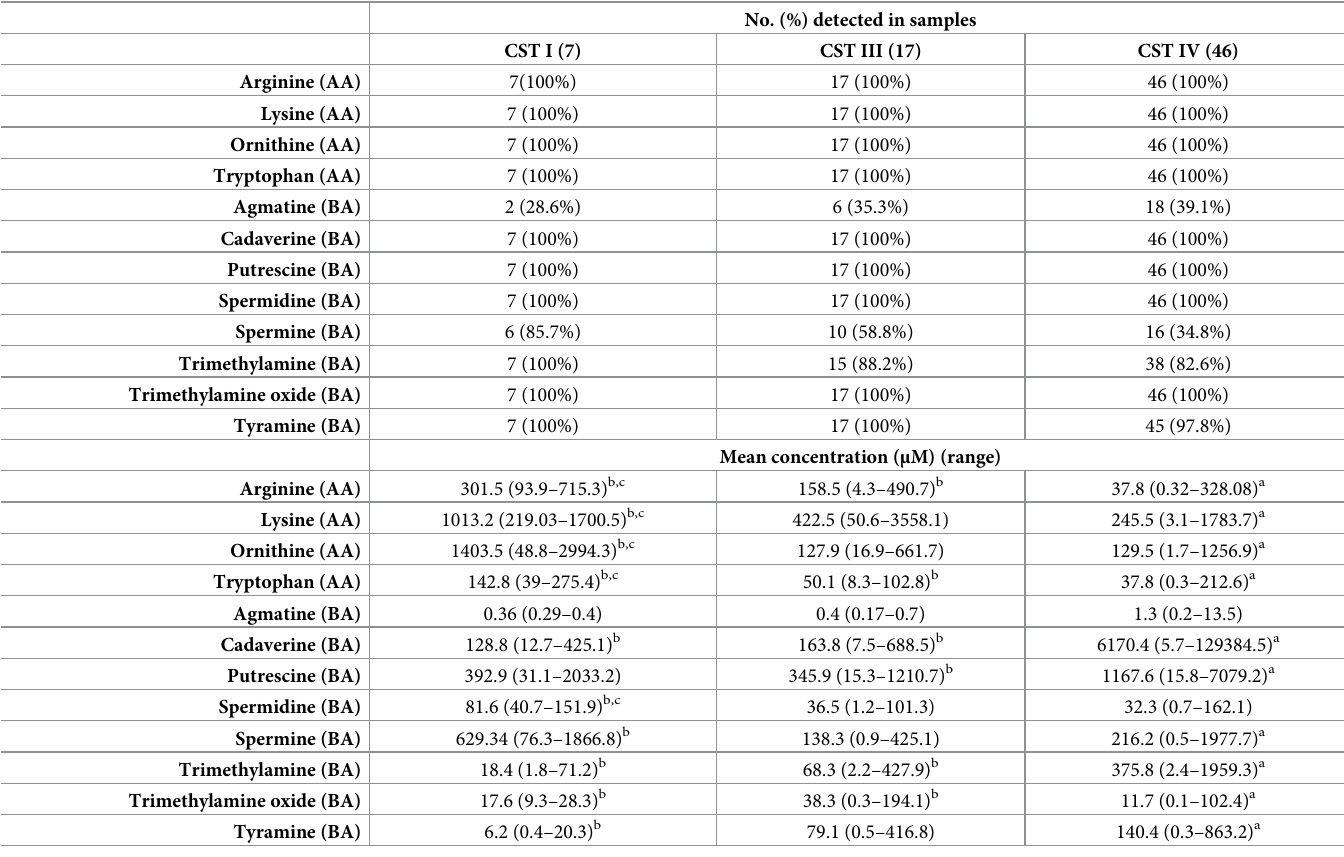
Table 2. Physiological concentrations of biogenic amines and amino acid precursors.